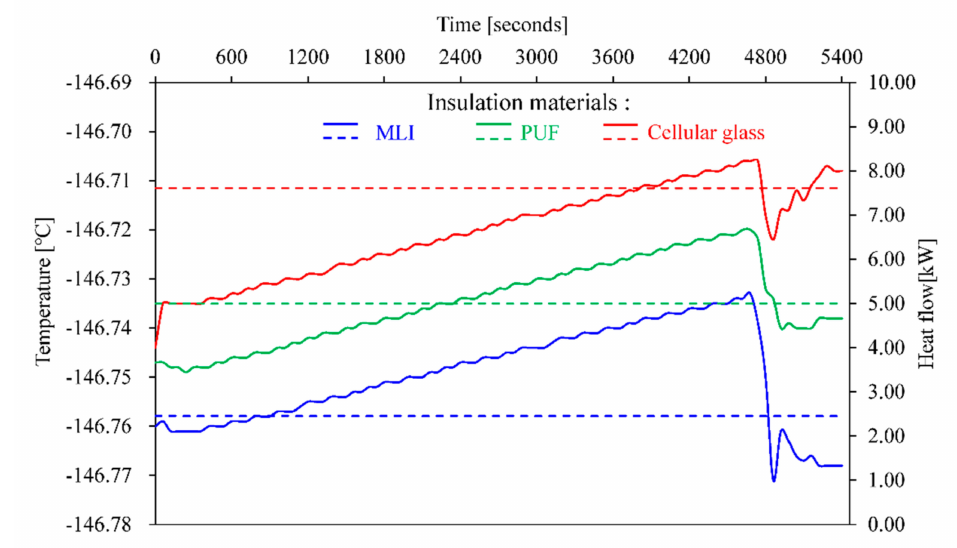
Figure 8. Variation of liquified natural gas (LNG) temperature at the receiving tank inlet for di ff erent insulation materials (solid line: temperature in receiving tank inlet, dotted line: heat flow through pipes).